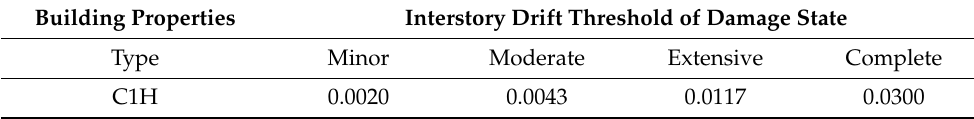
Table 6. Structural fragility curve parameters.